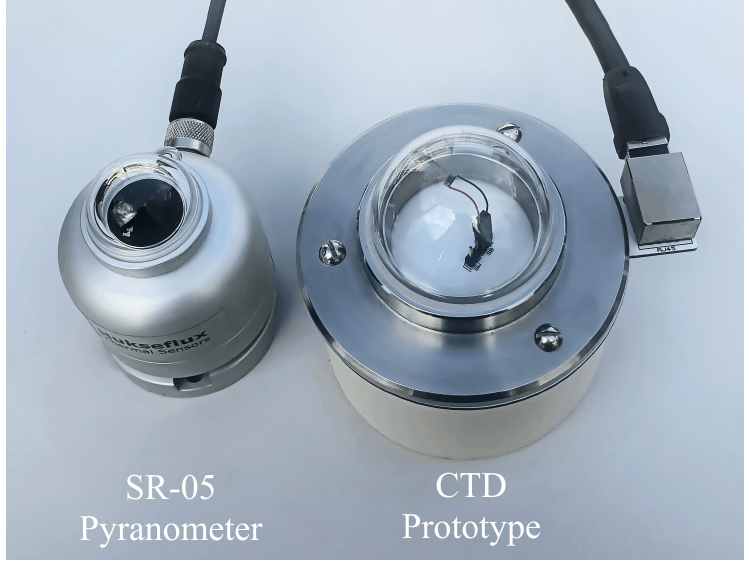
Figure 4. The SR-05 pyranometer and CTD